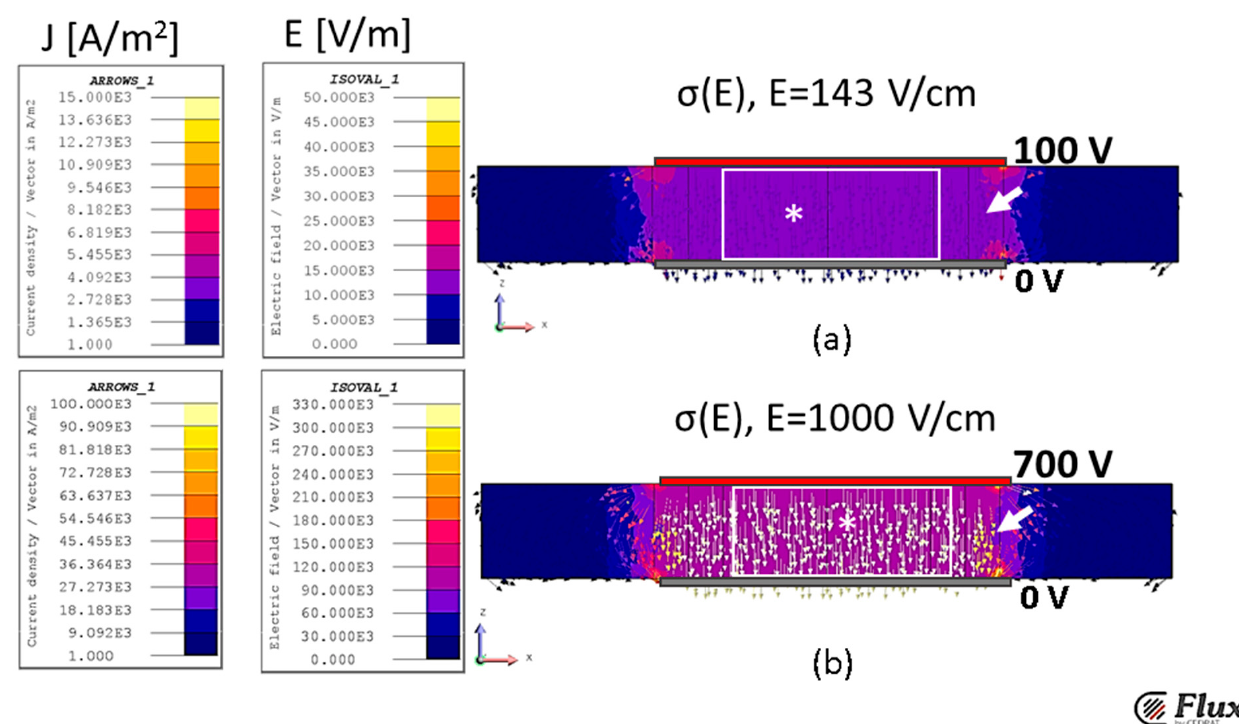
Figure 6. Electric field intensity and current density in the potato volume in the disk case with electric conductivity depending on electric field strength for different applied voltages, ( a ) 100 V, ( b ) 700 V